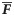
F¯ upon reaching theoretical saturation against Φc¯ for the values of k between 11 and 101.The blue dots represent random chance, the green diamonds represent minimal information, and the red triangles represent maximal information.